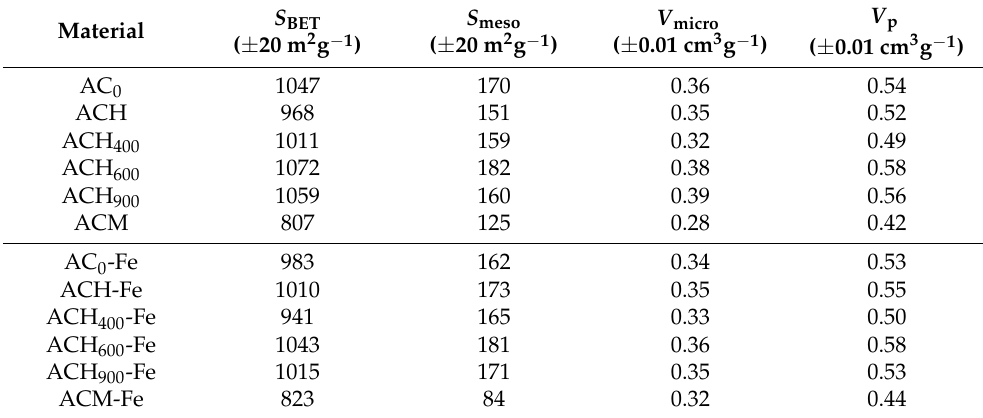
Table 2. Textural properties of the modified activated carbons and their respective iron-based